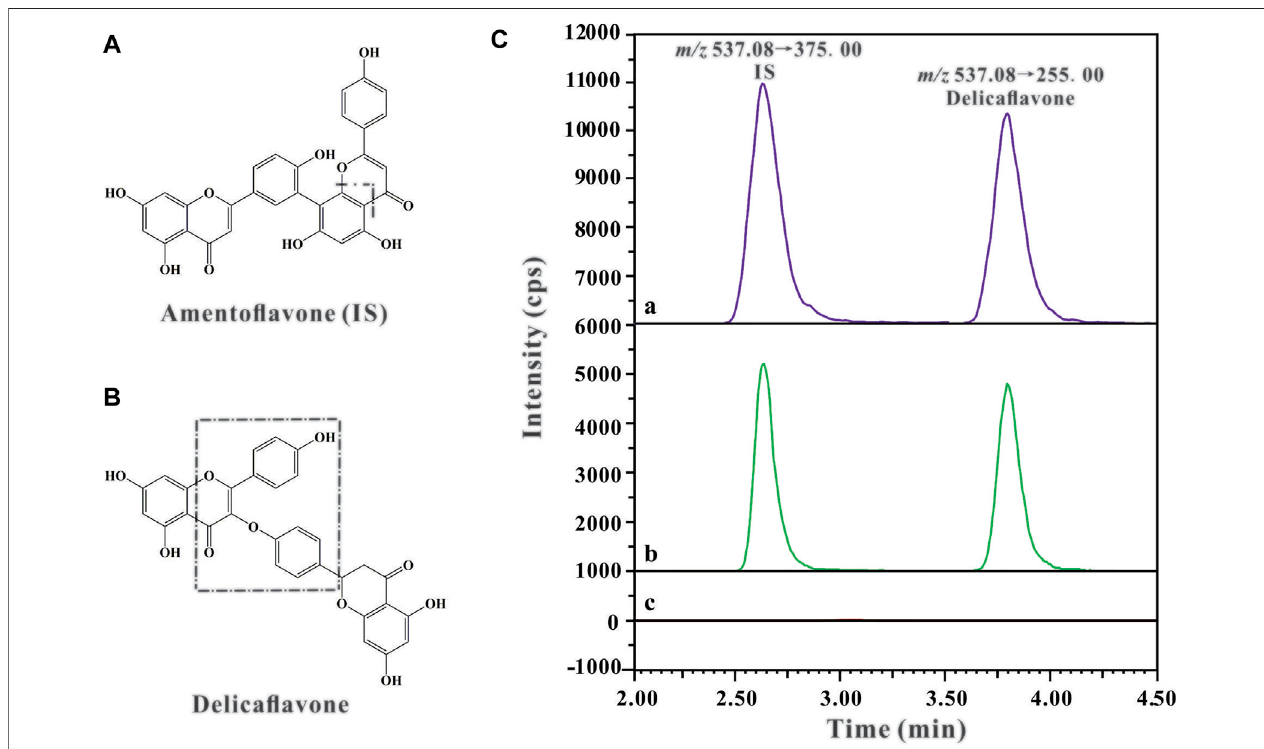
FIGURE 1 | The chemical structures and fragmentation schemes for (A) Amento fl avone (IS), (B) Delica fl avone, and (C) Representative chromatograms of IS (100 ng/ml) and DF in rat plasma sample: (A) Plasma sample collected from the rat 2 h after i.v. administration of DF at a dose of 4 mg/kg; (B) Blank plasma spiked with DF and IS; (C) Blank plasma